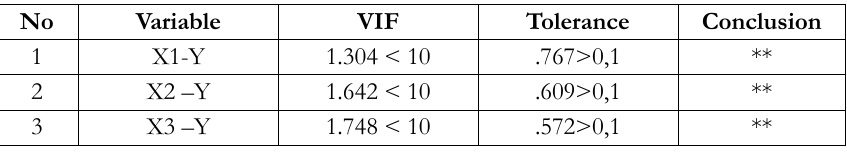
Table 4. Value of VIF and tolerance of research